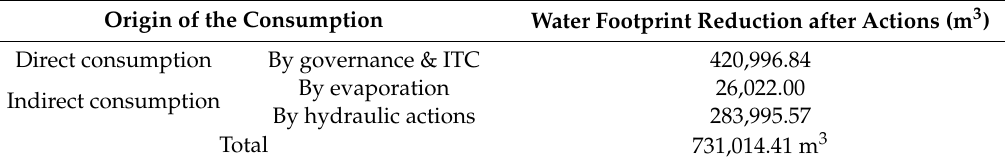
Figure 9. Waterproof sheet in reservoir to reduce evaporation. Source: Own. Table 5. Summary of water footprint reduction after actions. Source: Own elaboration.